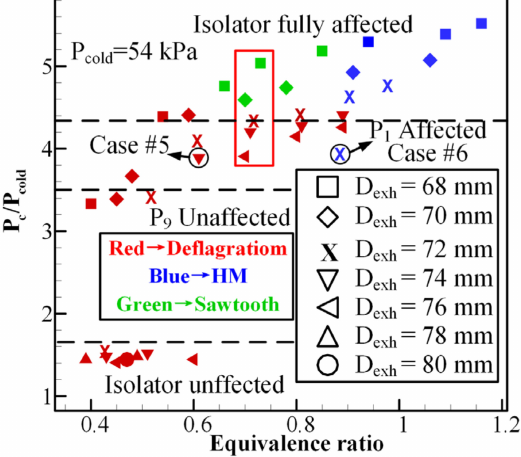
Figure 12. Combustor pressure distributions under different operating